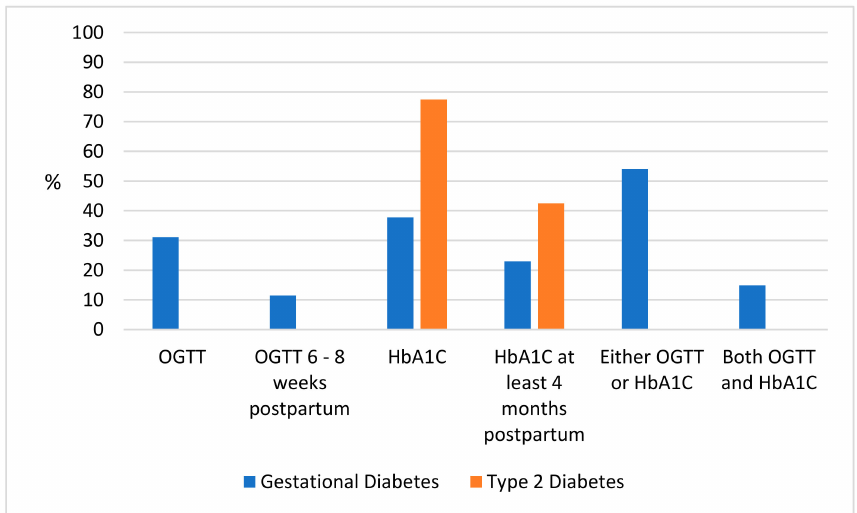
Figure 1. Glycaemic checks performed following hyperglycaemia in pregnancy at any time point in the 12 month postpartum period, in the Northern Territory, 2013–2014, by diabetes in pregnancy type. Data are